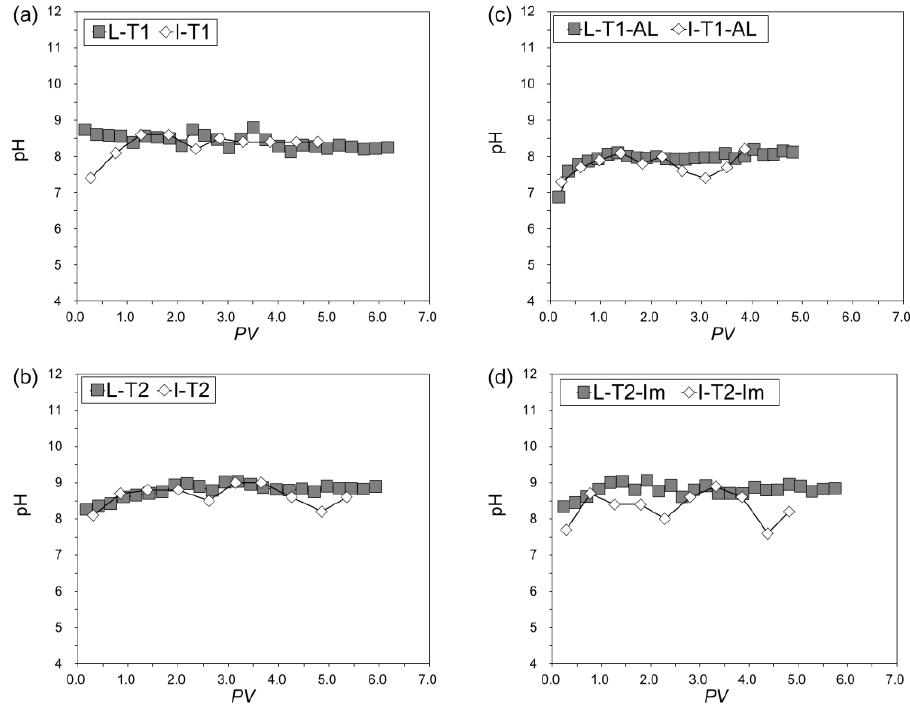
Figure 5. Changes in pH with PV ; ( a ) comparison betweenL-T1 and I-T1, ( b ) comparison between L-T2 and I-T2, ( c ) comparison between L-T1-AL and I-T1-AL and ( d ) comparison between L-T2-Im and I-T2-Im.